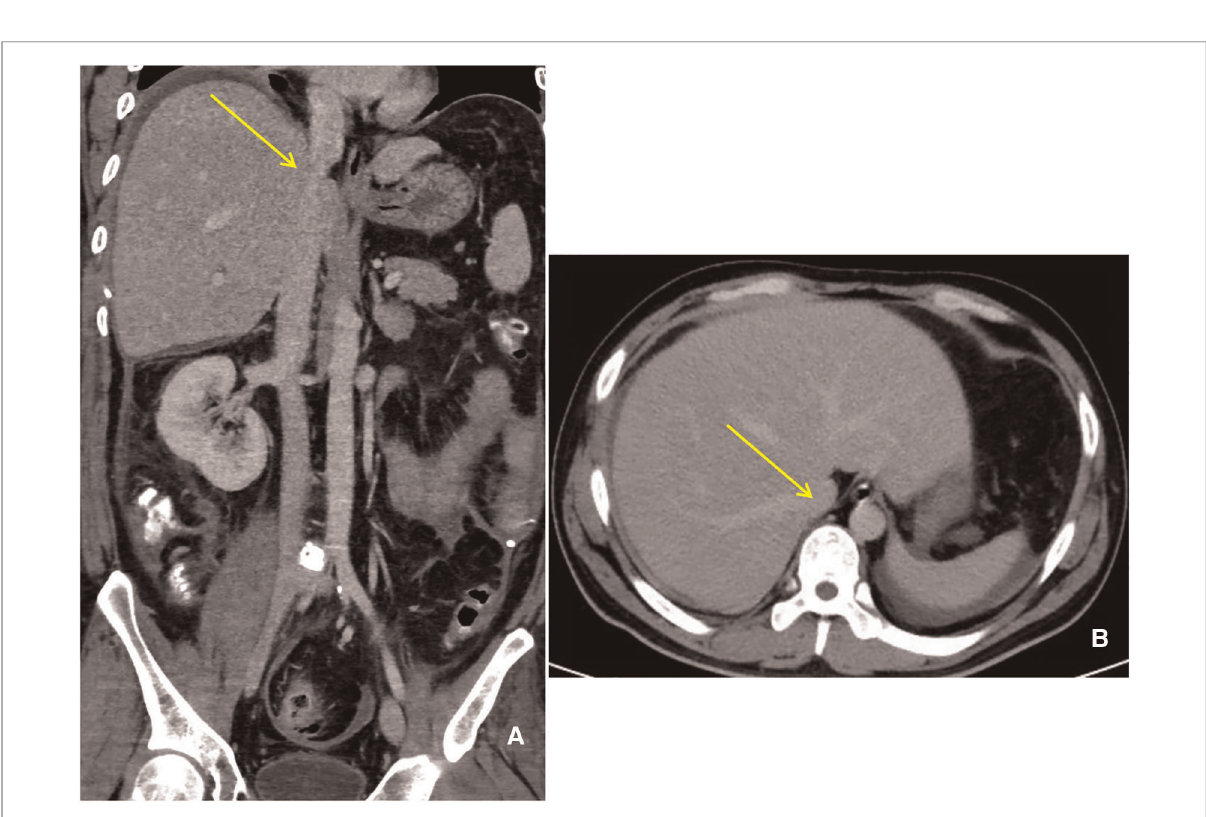
FIGURE 3 Signi fi cant improved on the compressed IVC (yellow arrow). ( A ) Coronal. ( B )